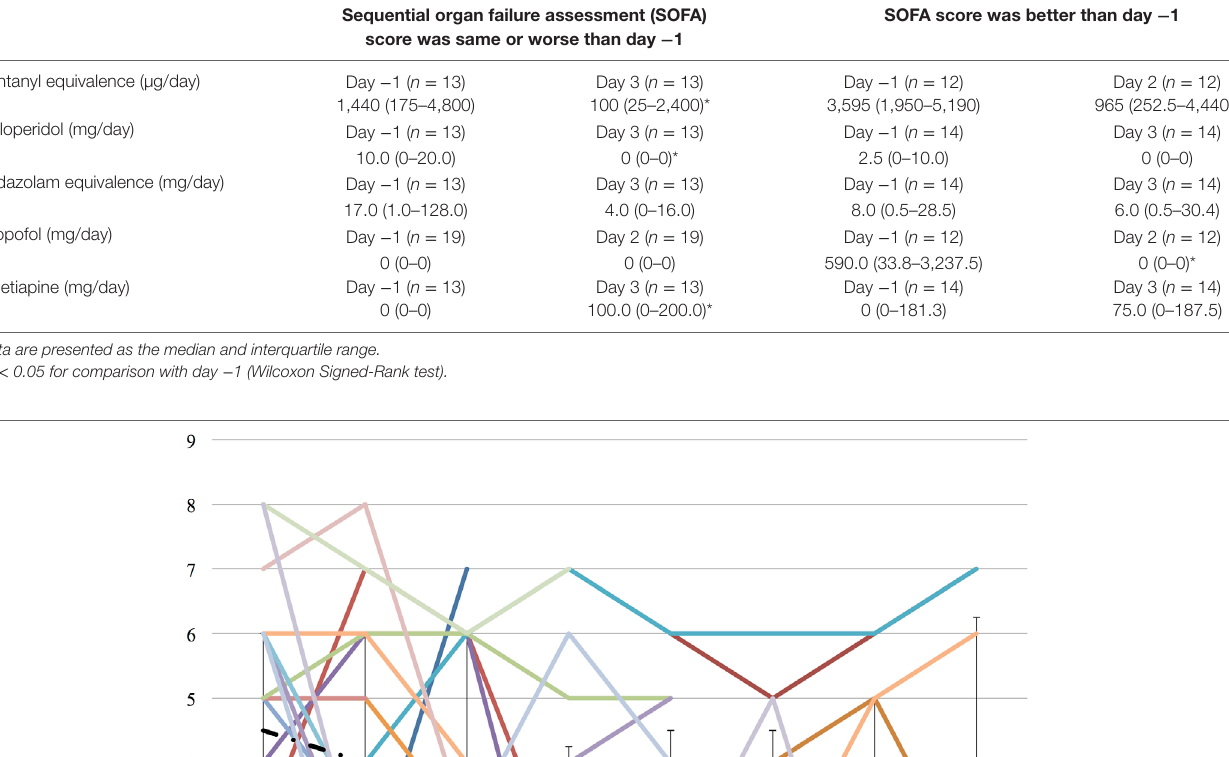
SOFa score was better than day − 1